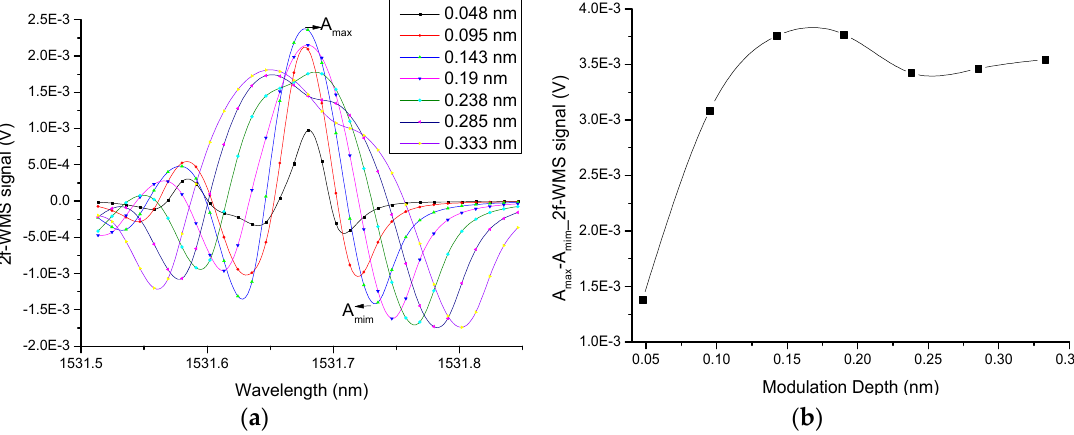
Figure 10. ( a ) 2f-WMS Photoacoustic signal for modulation depths from 0.048 nm to 0.333 nm of the same NH 3 absorption lines. ( b ) Peak to peak 2f-WMS photoacoustic signal as a function of the modulation depth. All measurements were performed with a 5000 ppmv NH 3 in N 2 mixture,